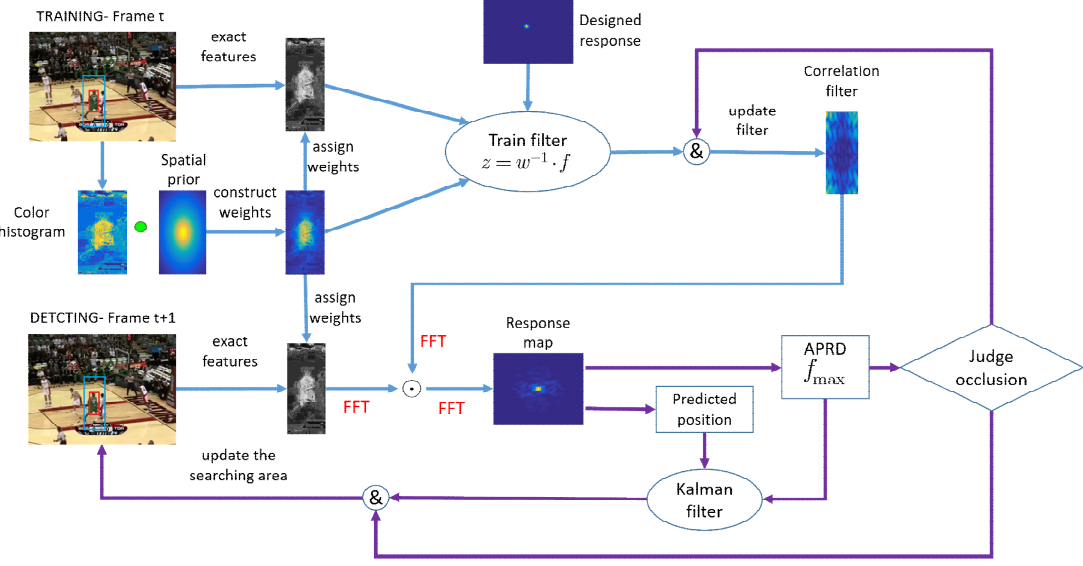
Figure 2. Main components of our tracking framework. The whole improved methods are represented by blue lines and purple lines. The blue lines denote the improving correlation filter with adaptive weights, which aims to enhance the target feature and suppress the background distractors. The purple lines denote the treatment to occlusion, which can prevent the target template from occlusion pollution and ensure that the target after occlusion can be redetected at the updated searching area.